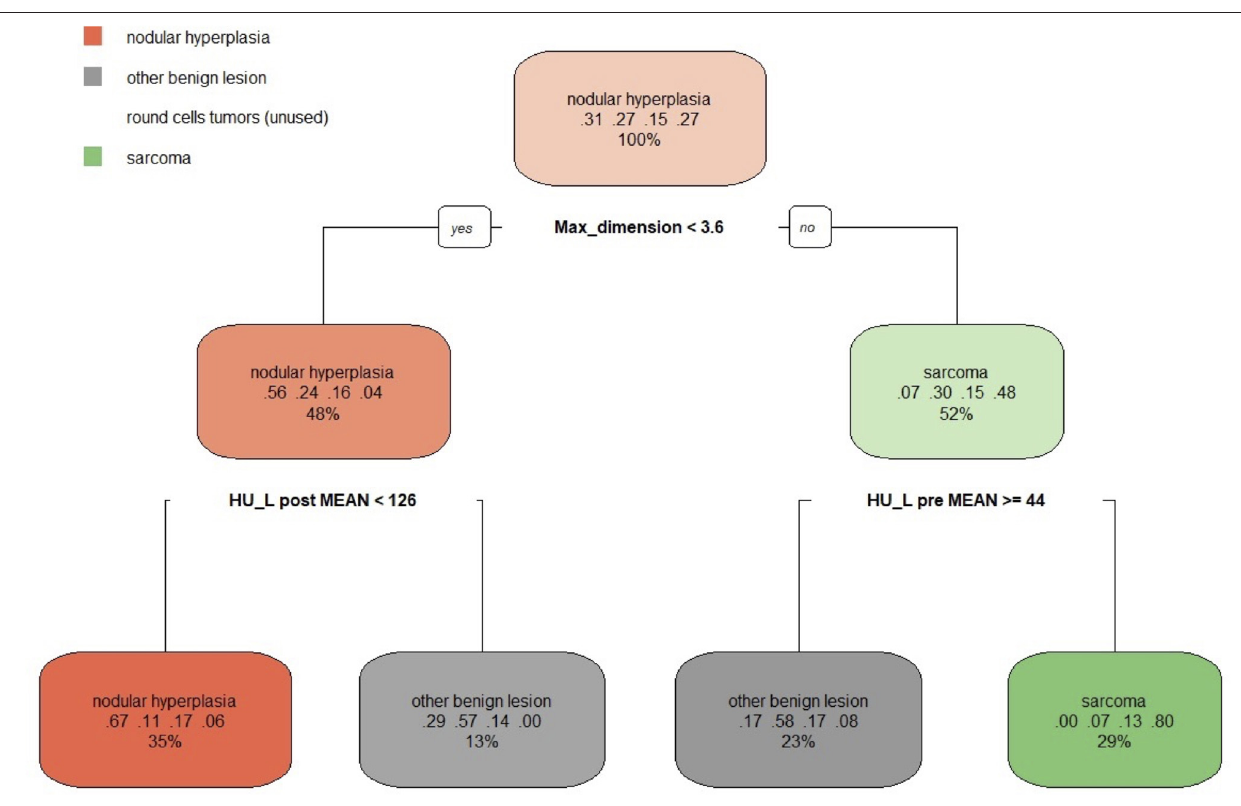
FIGURE 7 | The machine learning-based decision tree developed on the qualitative and the quantitative CT features of the focal splenic lesions. The second line in each box shows the probability of each class at that node (i.e., the probability of the class conditioned on the node) and the third line shows the percentage of observations used at that